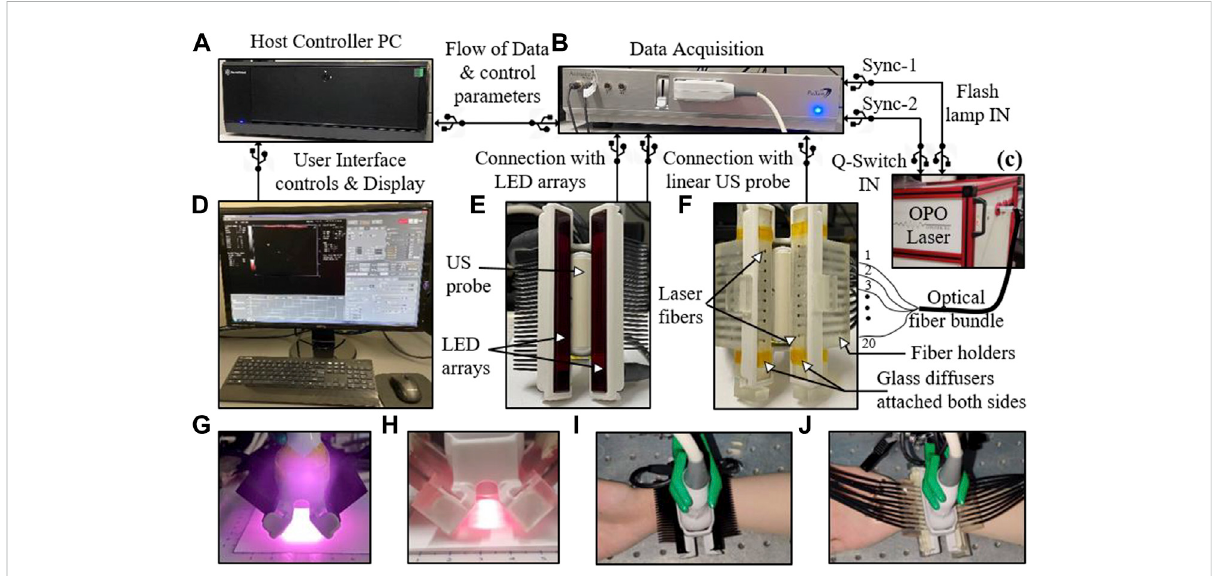
FIGURE 2 The experimental setup designed for comparing light-emitting diode (LED)-based and high-power laser-based PAT and US imaging. (A) A host controller PC; (B) DAQ hardware; (C) A portable high-power laser with its output coupled to the input end of an optical fi ber bundle; (D) Computer display:displaysPAT(redscale),B-modeUS(grayscale),andcoregisteredPAT/US(overlaidredPATongrayUS); (E) Arrangementoftwo850 nmLED arrays around the US probe; (F) Arrangement of twenty laser fi bers inserted into the two fi ber holders around the US probe; (G,H) Optical illumination pro fi le achieved with two LED array sources and laser sources, respectively; (I,J) Pictures of a human wrist under imaging with the LED and laser arrangements, respectively. LED: light-emitting diode; PAT, photoacoustic tomography; US, ultrasound; DAQ: data acquisition; PC: personal computer. Reprinted with permission from [Agrawal S., Singh M. K. A., Johnstonbaugh K., Han D. C., Pameijer C. A., and Kothapalli S-R. (2021). Photoacoustic Imaging of Human Vasculature Using LED versus Laser Illumination: A Comparison Study on Tissue Phantoms and In